Question: How would you classify this visualization?
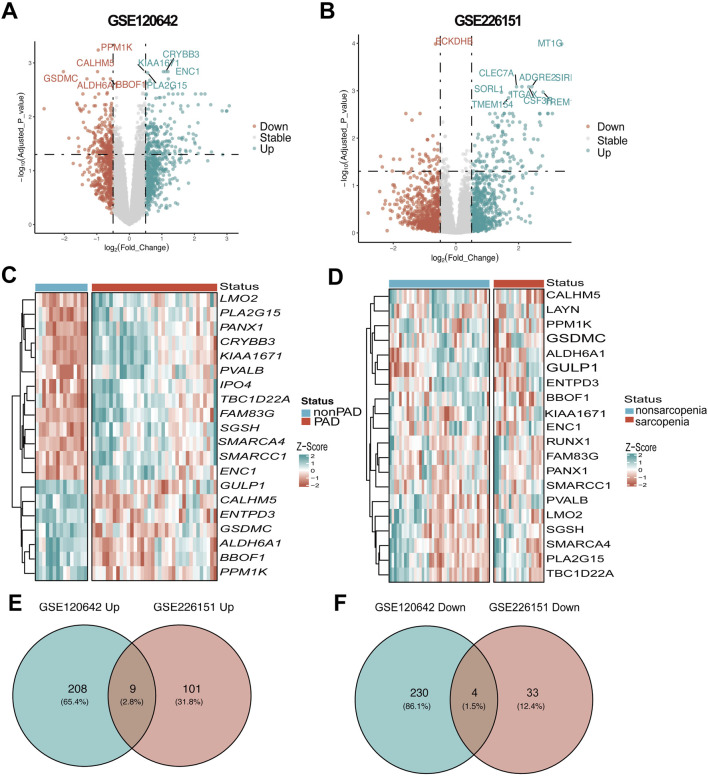
Answer: heatmap